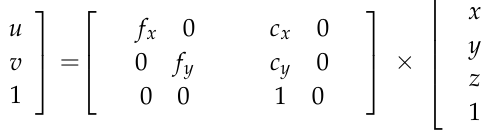
Figure 4. Calculation of the angle to the master robot.